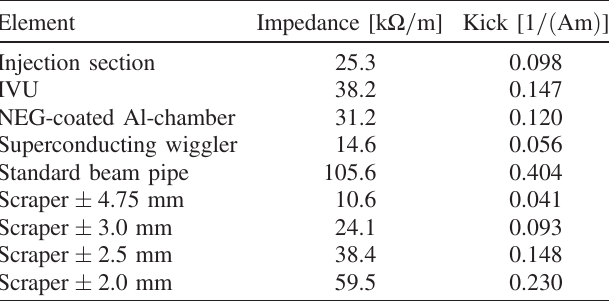
TABLE II. ALBA storage ring vertical impedance budget. Standard beam pipe refers to the overall contribution of the standard vacuum chamber used in most parts of the machine. The IVU value corresponds to the minimum gap (6 mm), while being negligible at full open position. The contribution of the vertical scraper has been characterized for different gaps other than the nominal position at (cid:2) 4 . 75 mm, in all cases the jaws aperture was kept symmetric with respect to the beam.